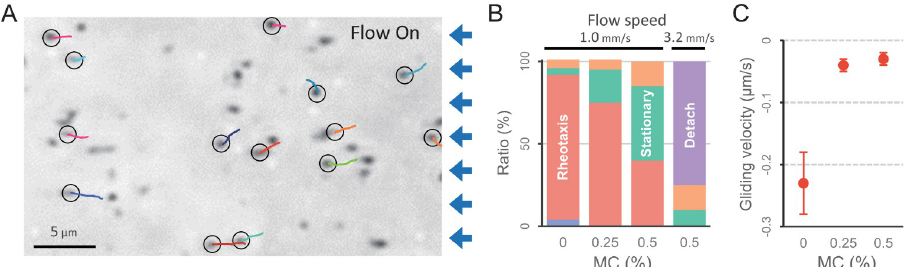
Fig 3. Rheotaxis of M . pneumoniae in a viscous environment. (A) Field image of cell behavior in the presence of 0.25% methylcellulose (MC). Fluid flow at 1 mm/s was applied. Cell trajectories for 40 s (color lines) were plotted on the phase-contrast images. The start position of a trajectory is marked by the black circle. The blue arrows on the right side of the image represent the direction of the fluid flow. (B) Fraction of cell motility pattern. The motility pattern under fluid flow was categorized into five groups at each MC concentration ( N = 30). The color code and the definitions are the same as those presented in Fig 2B. (C) Cell gliding velocity. The average and SD of cell gliding velocity during positive rheotaxis are shown ( N = 30).